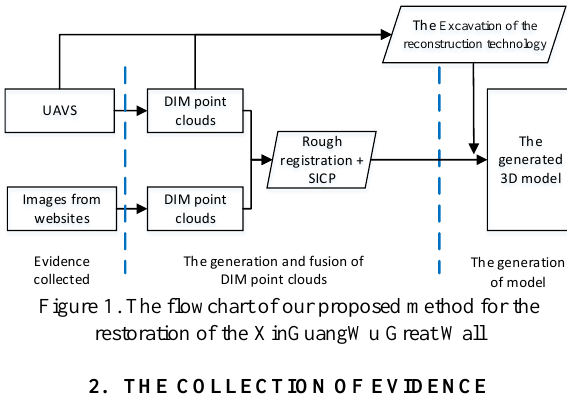
Figure 1. The flowchart of our proposed method for the restoration of the XinGuangWu Great